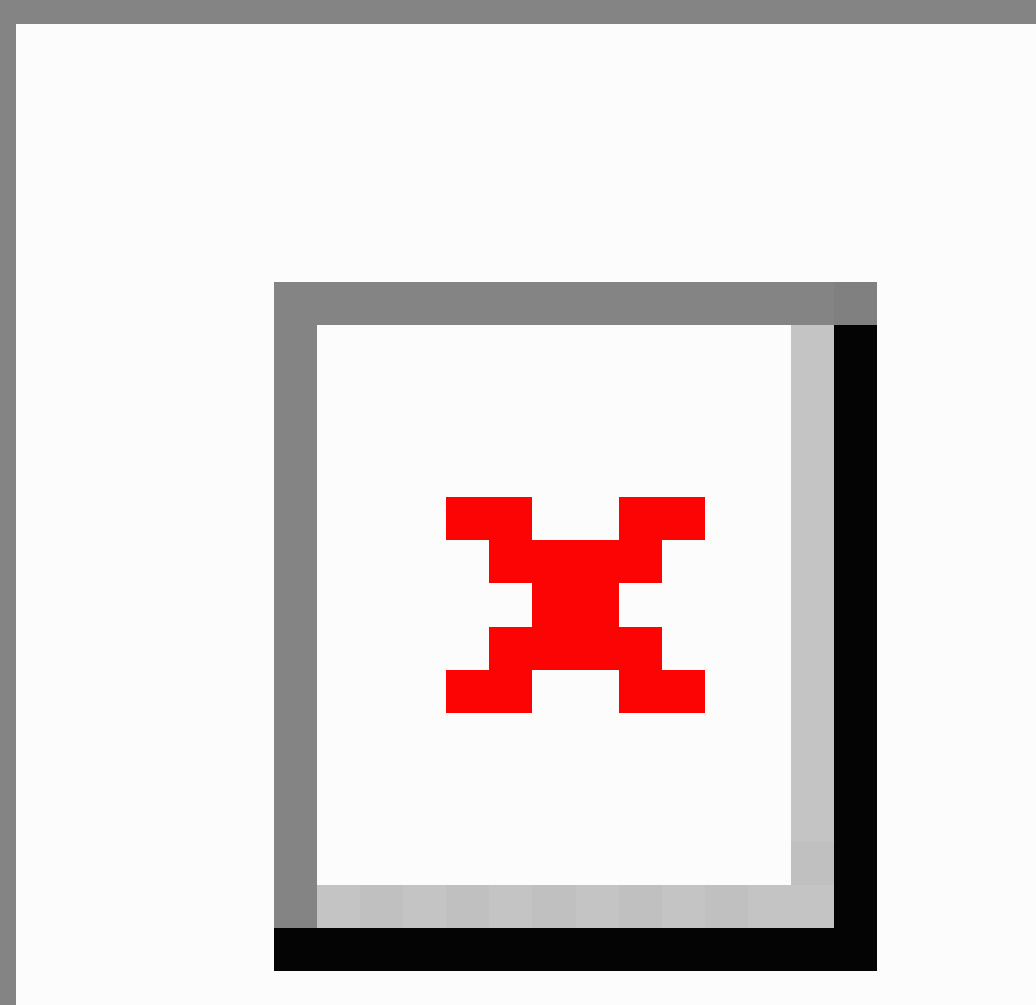
Figure 5. Frequency of daily visits from the Start Strong website, 2010-2012, generated in Google